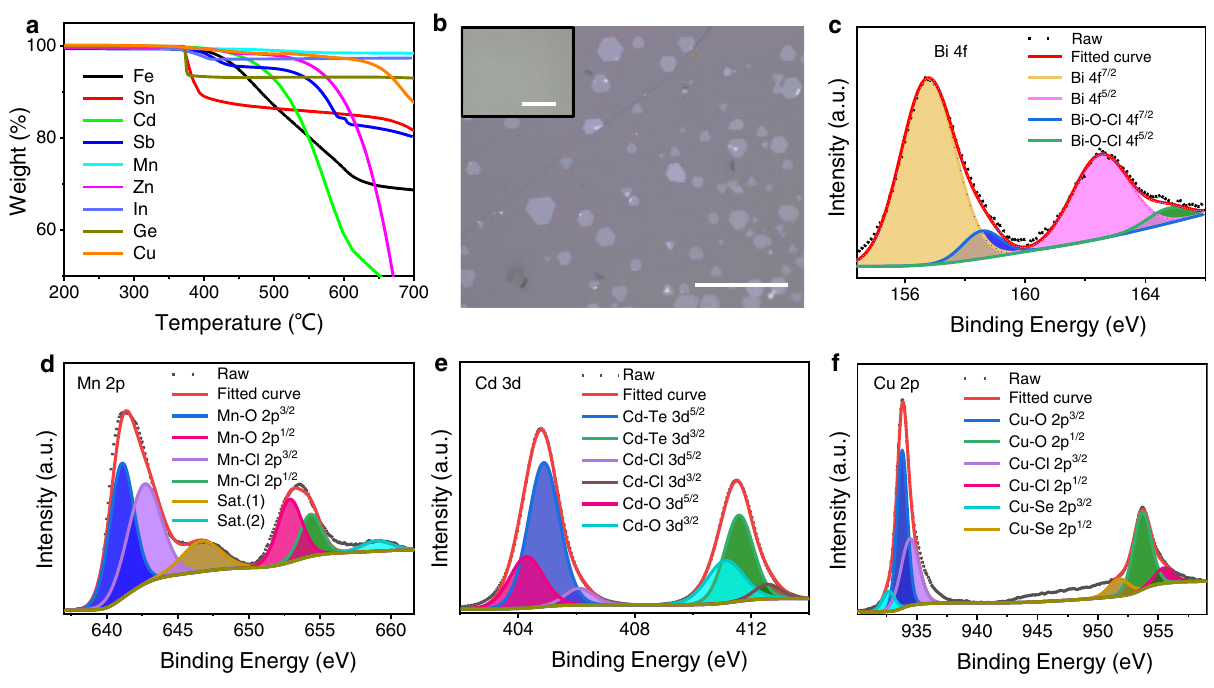
Fig. 4 | Low temperature growth mechanism of the BiOCl-assisted CVD method. a Thermogravimetric analysis after mixing metal and basic salt BiOCl homogeneously. b Comparison of the growth of MnSe with and without BiOCl